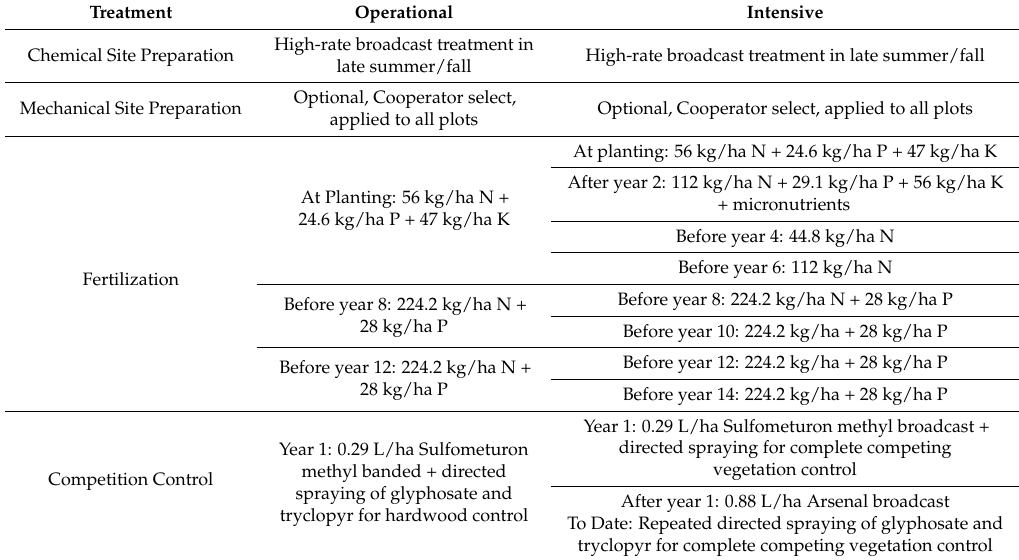
Table 2. Detail of cultural regimes utilized in the PMRC SAGS Culture × Density study through age 15.